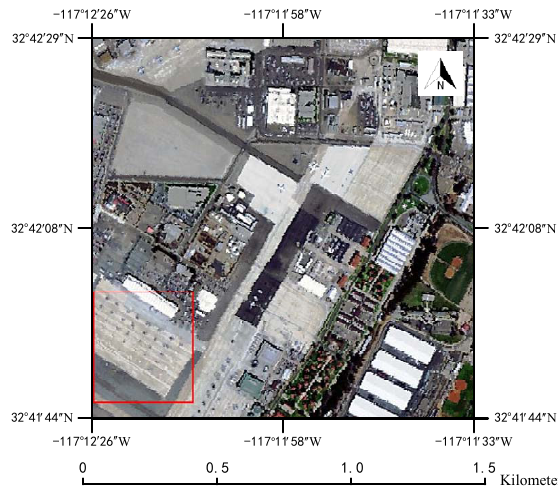
Figure 5. The colour image of Sandiego airport HSI